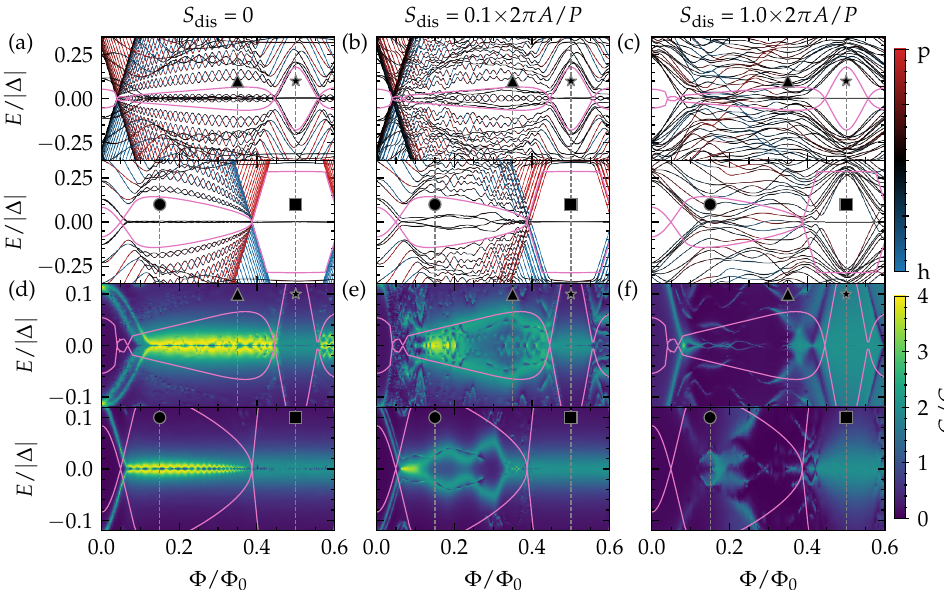
Figure 3. The ( a – c ) low-energy quasiparticle spectrum of a top-proximitized TI nanoribbon with finite length as a function of piercing magnetic flux Φ , and the ( d – f ) tunneling conductance as a function of piercing magnetic flux and energy E (or bias over the tunneling junction). The pink lines correspond to the spectral gap in the TI nanoribbon with infinite length and without disorder. The top (bottom) panel of each subfigure corresponds to the upper (lower) horizontal line cut shown in Figure 1c at µ 1.3 2 π A / P ( µ 0.75 2 π A / P ). The results are obtained ( a , d ) without disorder, ≈ × ≈ × and ( b , c , e , f ) with disorder (considering S dis = 0.1 2 π A / P in ( b , e ), and S dis = 2 π A / P in ( c , f ), with × the different disorder strengths also indicated in Figure